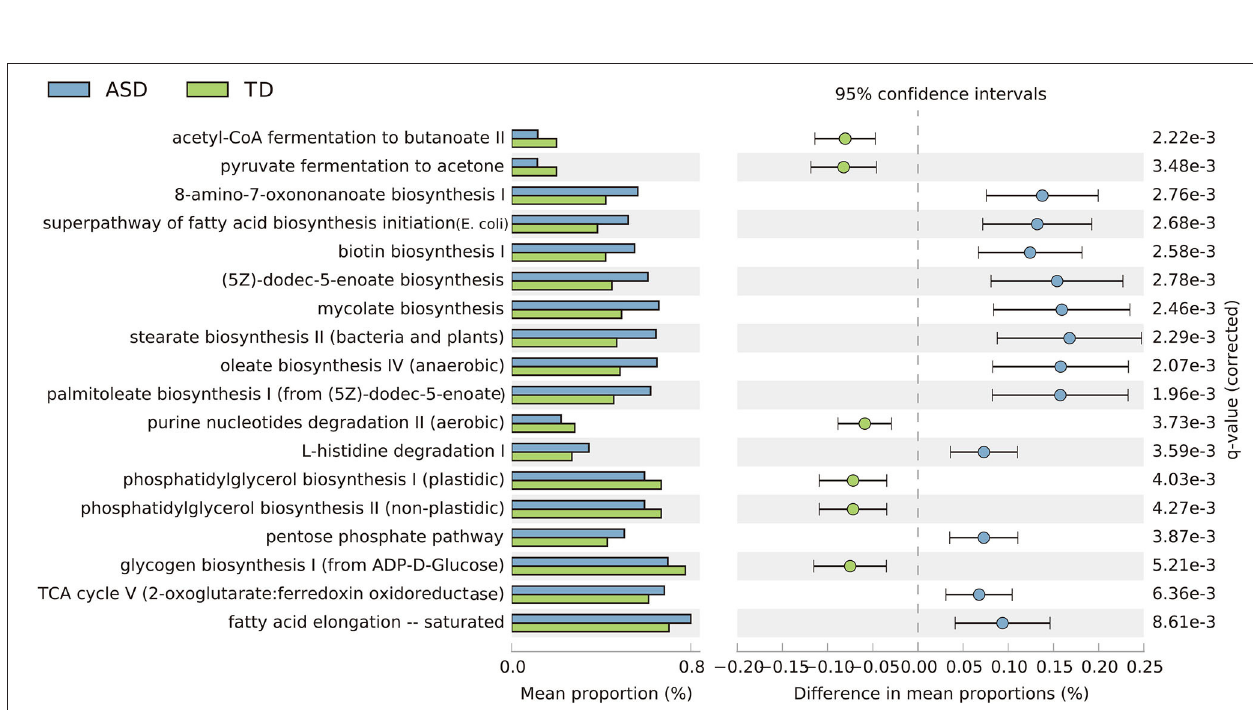
and intellectual state, for the ASD population and/or those with intellectual